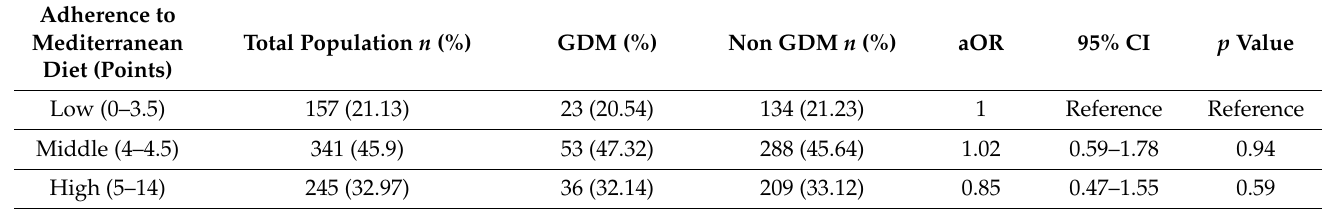
Table 5. Level of adherence to modified MDS, in total and by GDM status and likelihood of GDM by level of modified MDS adherence, using multiple logistic regression analysis. Modified MDS.